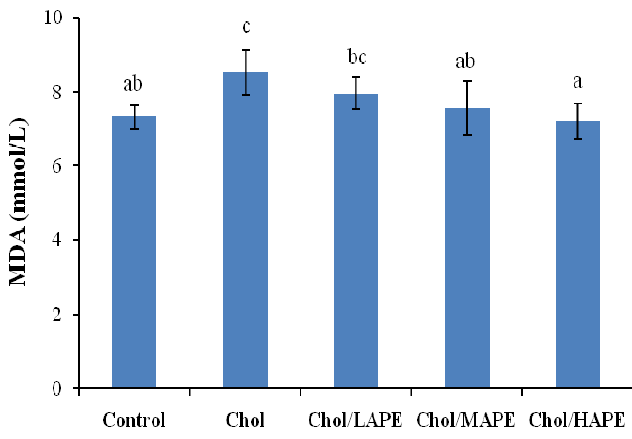
Figure 2. Effect of APE on serum MDA level in rats. Values are expressed as mean ± SD. Bars not sharing common letter superscripts are significantly different ( p <